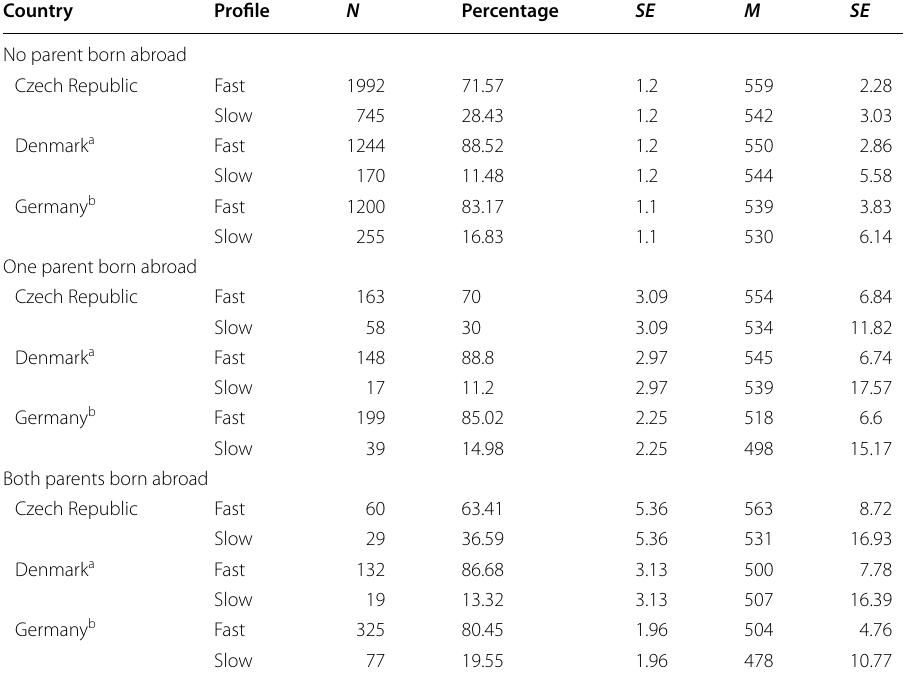
a Did not meet sample requirements